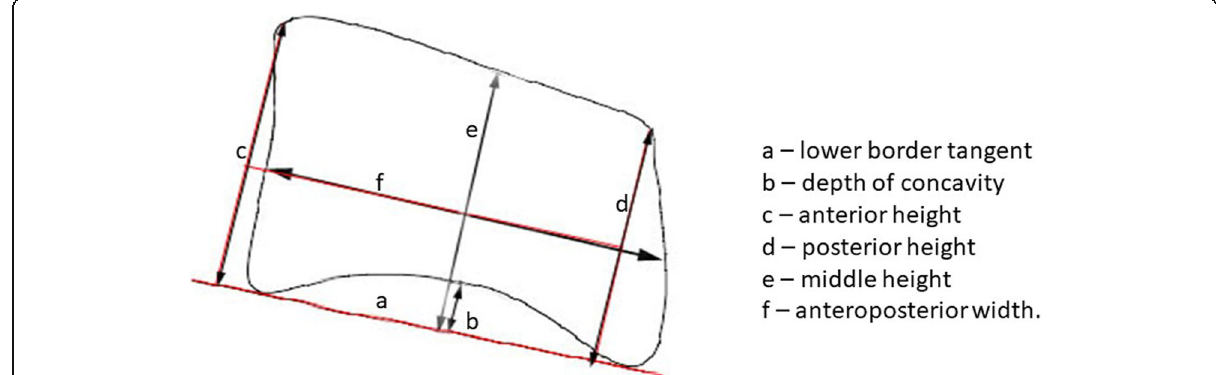
Fig. 1 Measurements made on the C3 and C4 cervical